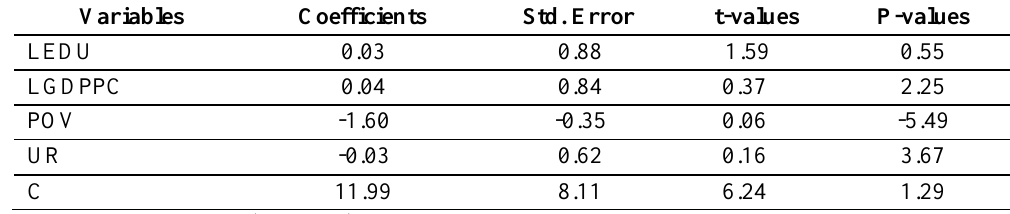
Table.5. Long-run Results using ARDL Approach (India)